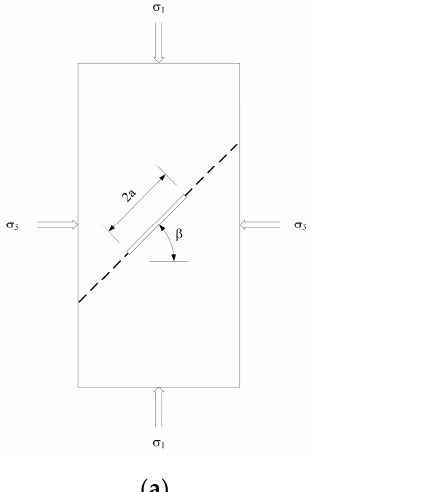
Figure 12. Relationship between the loading rate and fracture strength for determining the subcritical crack growth parameter under monotonic loading.